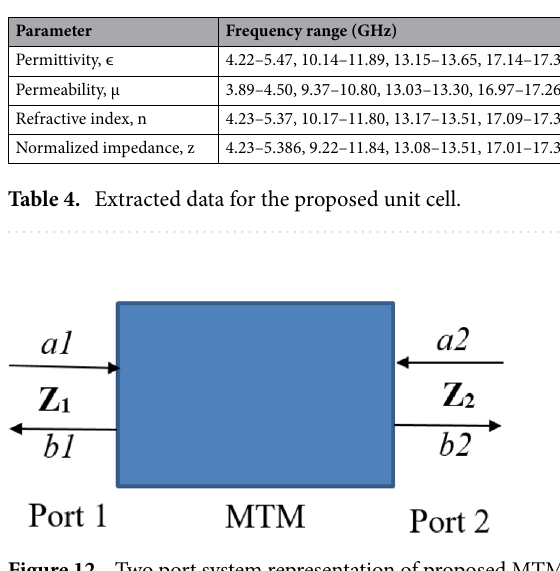
Figure 12. Two port system representation of proposed